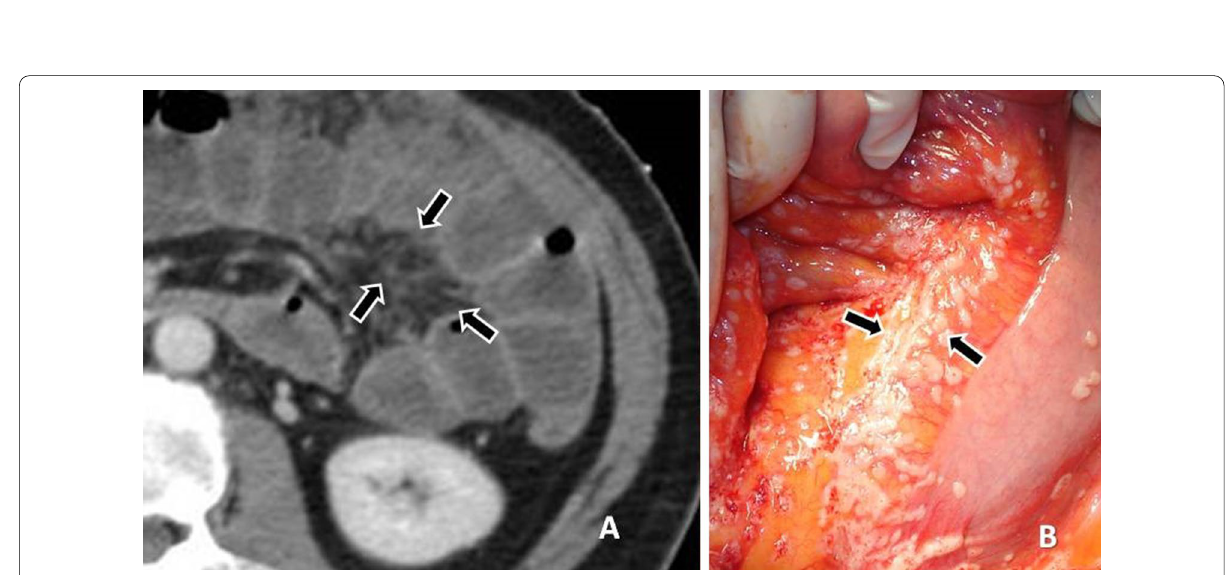
Fig. 11 a CT enteroclysis image discloses increased attenuation and stranding of the mesenteric fat (arrows). b At surgery the CT finding is produced by multiple tiny implants on the small bowel mesentery